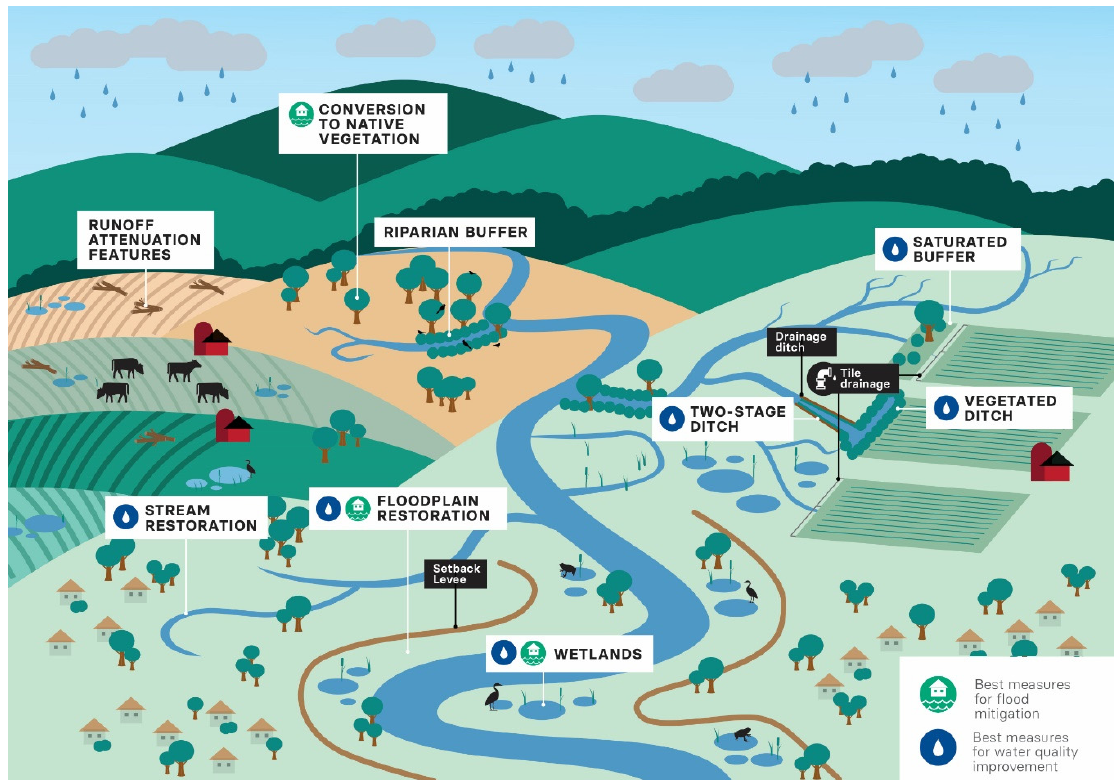
Figure 5. Example of different NI measures in different landscape positions throughout a watershed.